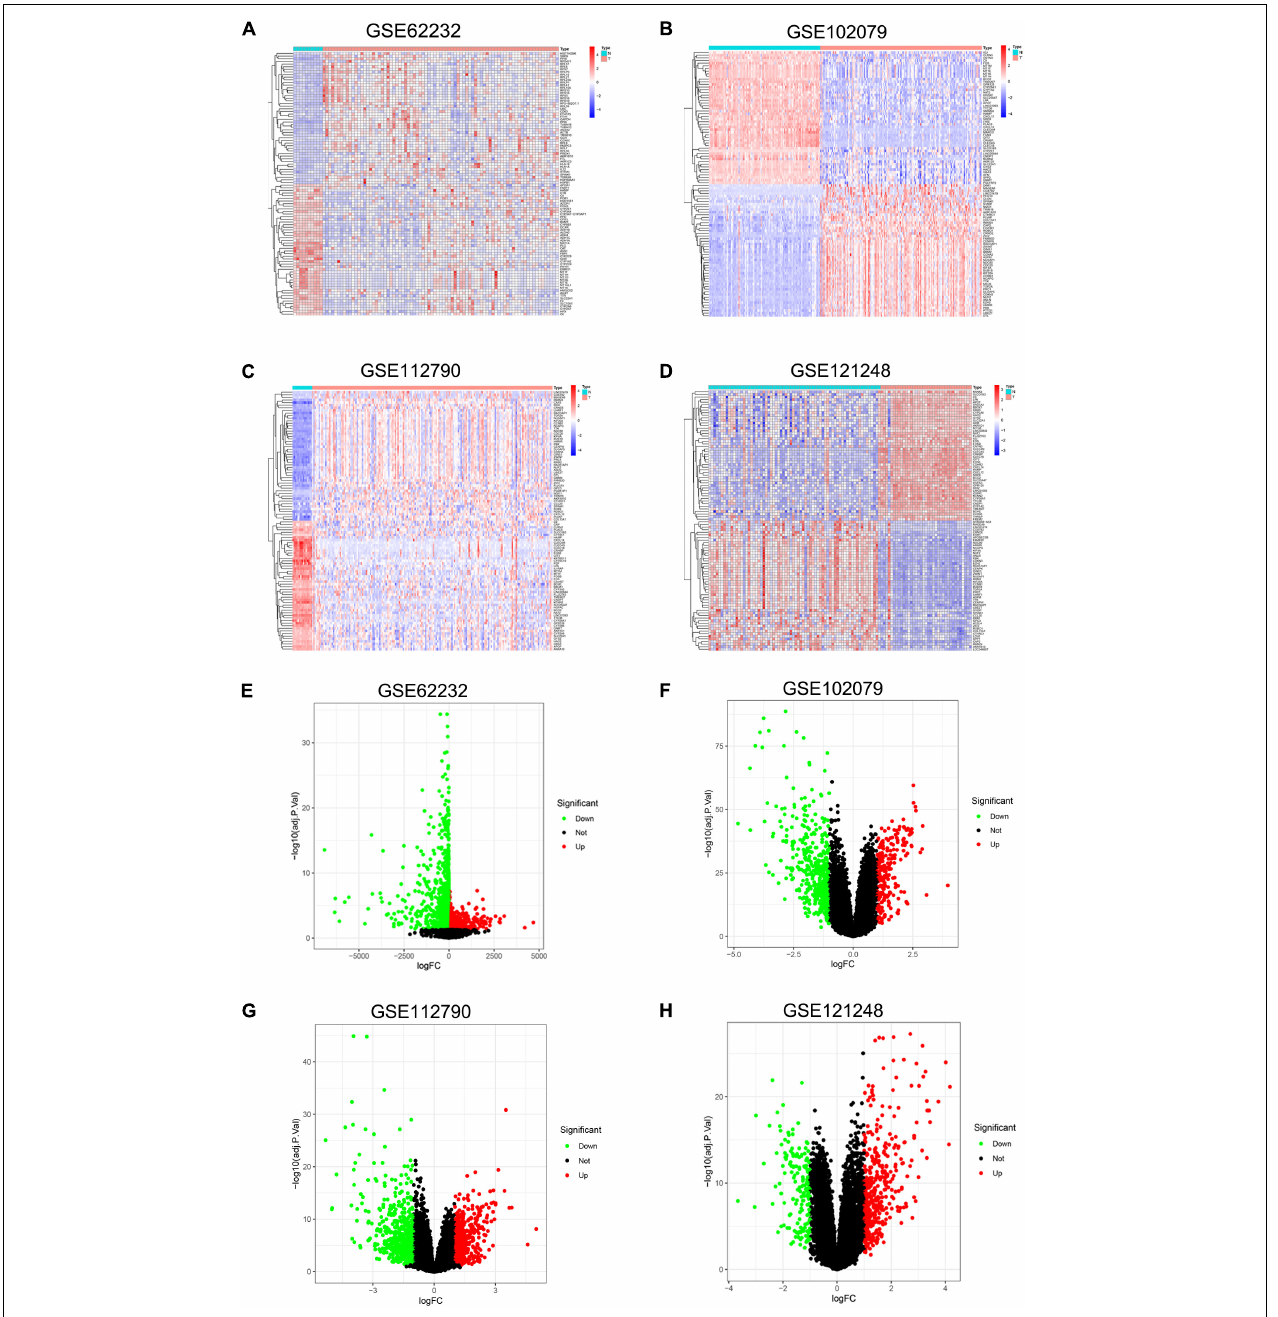
FIGURE 1 | Heatmap and volcano plot of DEGs in GSE62232, GSE102079, GSE112790, and GSE121248. (A) Heatmap of DEGs in GSE62232. (B) Heatmaps of DEGs in GSE102079. (C) Heatmaps of DGEs in GSE112790. (D) . Heatmaps of DGEs in GSE121248. (E) Volcano plot of DEGs in GSE62232. (F) Volcano plot of DEGs in GSE102079. (G) Volcano plot of DEGs in GSE112790. (H) Volcano plot of DEGs in GSE121248. In heatmaps, red color represented high expression level and blue color represent low expression level. In volcano plots, red dots were upregulated genes and green dots were downregulated genes.